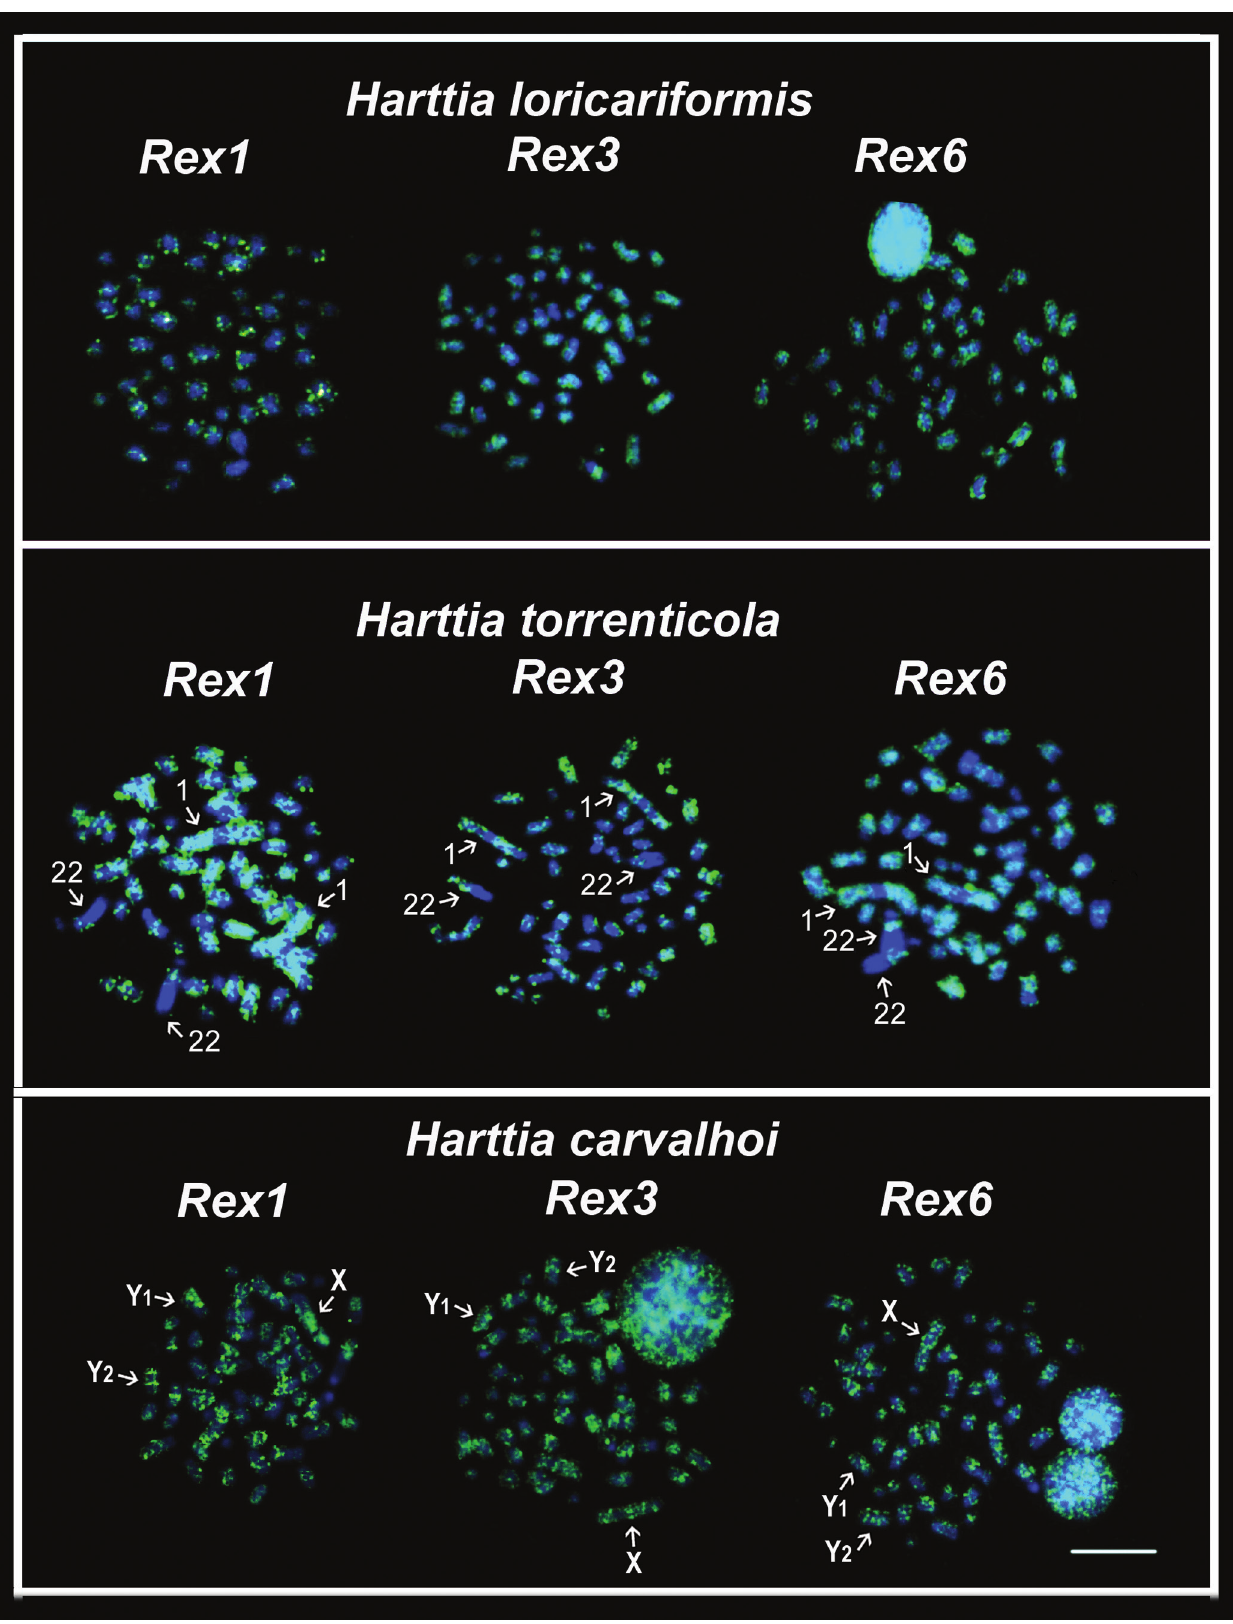
Fig. 2. Metaphases of the Harttia species submitted to FISH with probes of the Rex elements. The numbers indicate chromosomal pairs in highlighted. Bar = 10